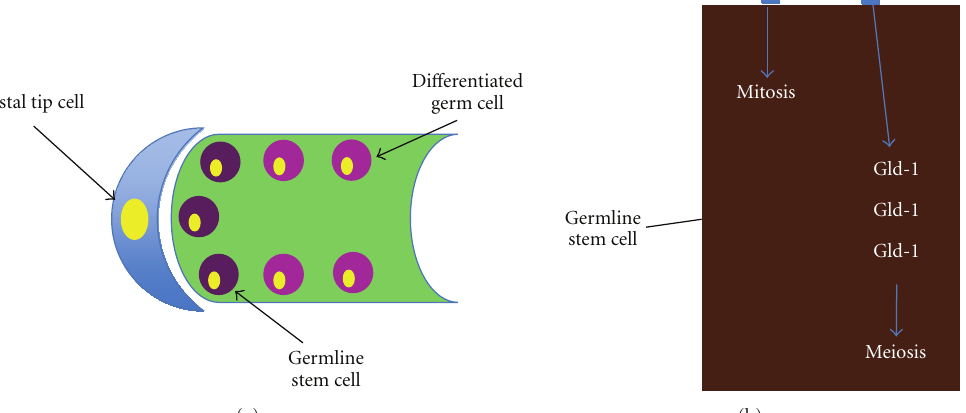
Figure 1: Asymmetric cellular division and signaling in the C. elegans germinal stem cell niche. (a) C. elegans is composed of a distal tip cell (blue), which maintains a niche for the germline stem cells (dark purple) and di ff erentiated germ cells (pink). (b) Binding of Lag-2, which is expressed on the distal tip cell, to the Glp-1 receptor (expressed on the germline stem cell) leads to mitosis. If Lag-2 does not bind to Glp-1, Gld-1 accumulates in the cell, favoring